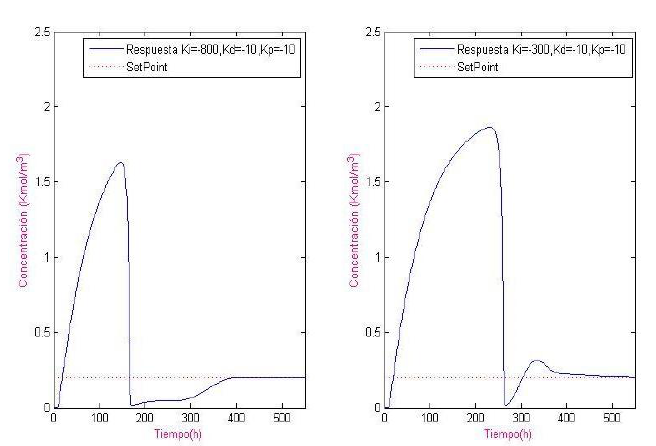
Figura 11: Respuesta transitoria del sistema para dos juegos de valores de las ganancias proporcional K del controlador K d